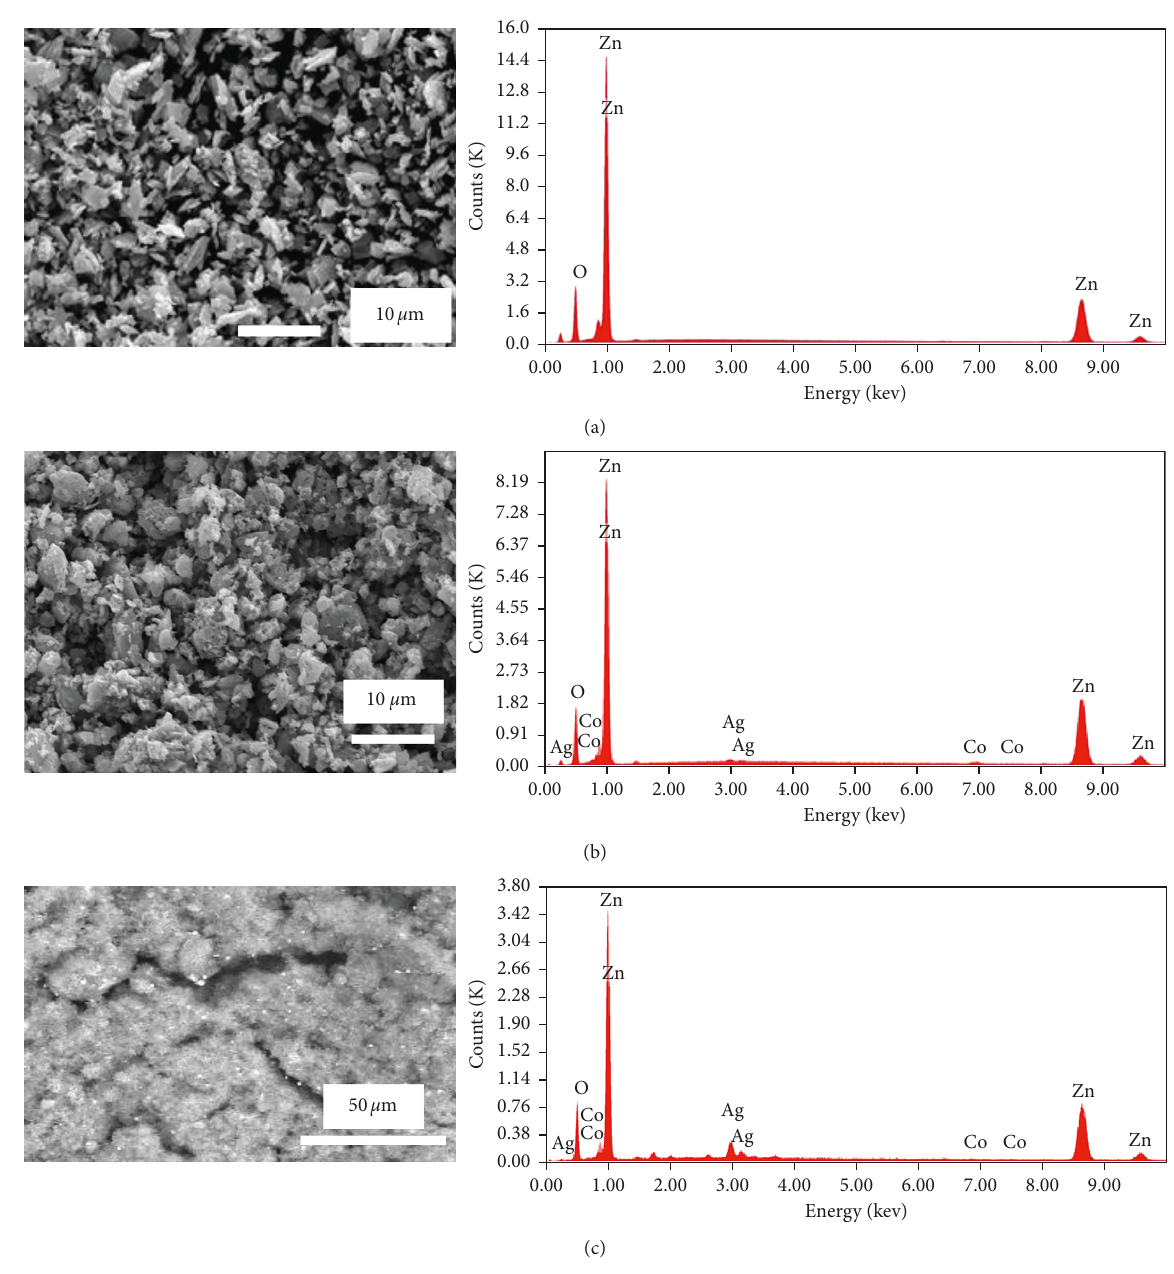
Figure 3: SEM images and EDX spectra of (a) C1, (b) C4 before used, and (c) C4 after the 4th